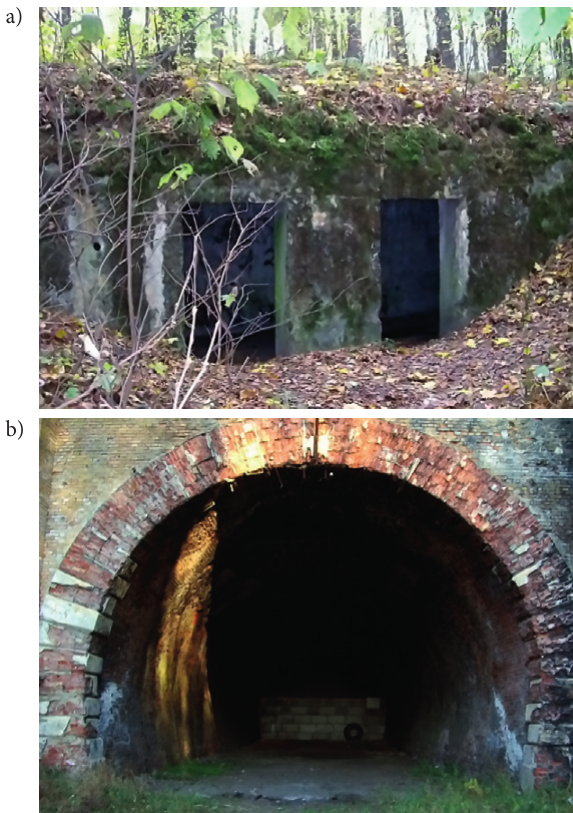
(http://vilniusguide.wordpress.com)a) Fig. 1. Examples of potential tourism objects in Vilnius: a) artillery fortifications in Belmontas; b) the Paneriai tunnel